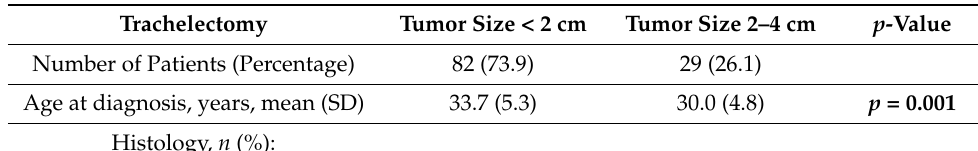
Table 1. Basal and surgical characteristics of both populations. LVSI: Lymph Vascular Space Invasion. MRI: Magnetic Resonance